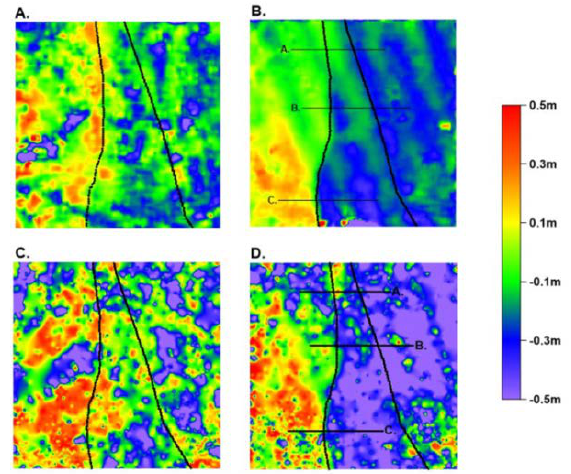
Figure 3. Displacement fields in the Y direction from geodetic marker point clouds. Fault traces shown by black lines. (A) ICP results of differenced point clouds from 2003 to September 2014. (B) ICP results of differenced point clouds from June 2014 to September 2014. (C) PIV results of differenced point clouds from 2003 to September 2014. (D) PIV results of differenced point clouds from June 2014 to September 2014. Location of profiles for Figure 5 shown by lines A, B, and The ICP results using bare earth point clouds are shown in Figure 2A and 2B. The 2003 to 2014 differencing is largely incoherent with average right lateral displacement of 5 cm east of the western fault trace and standard deviations as high as 19 cm. However, the June to September 2014 differencing shows a clear delineation of the main fault segment from left to right.